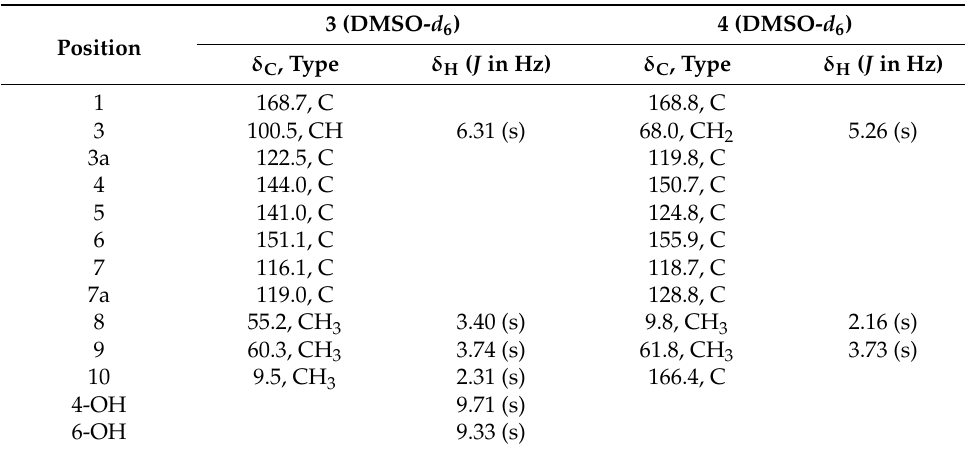
Table 2. 1 H (500 MHz) and 13 C (125 MHz) NMR data of 3 and 4 .